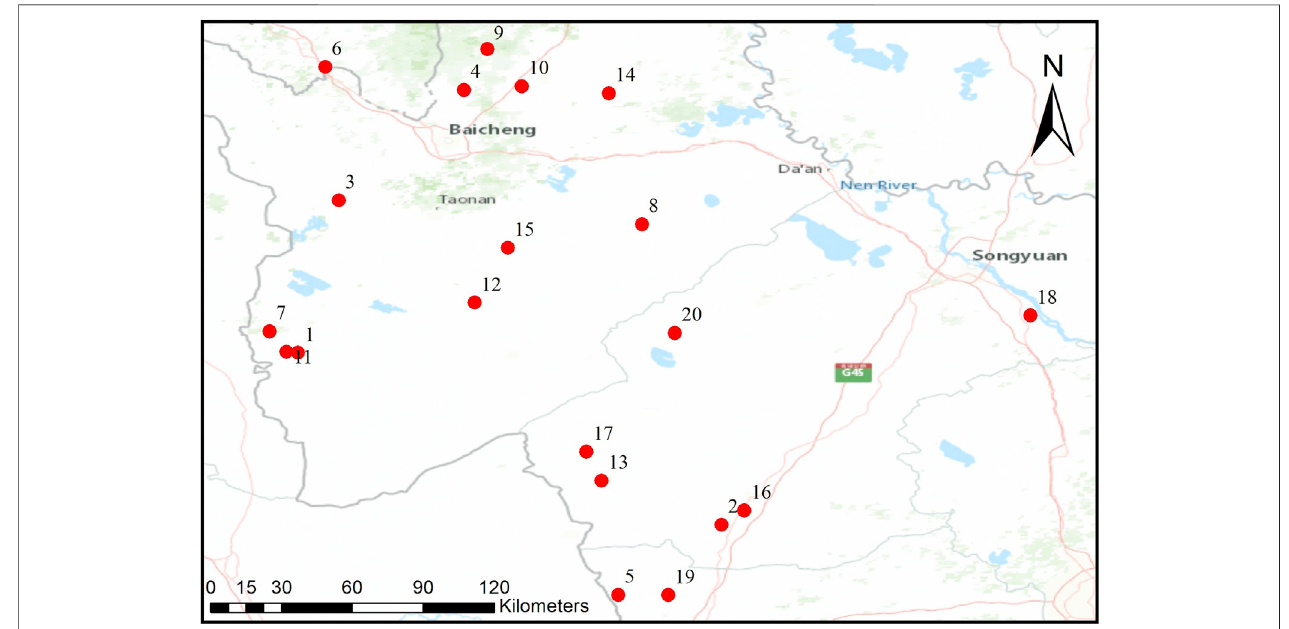
FIGURE 5 | The location of the wind